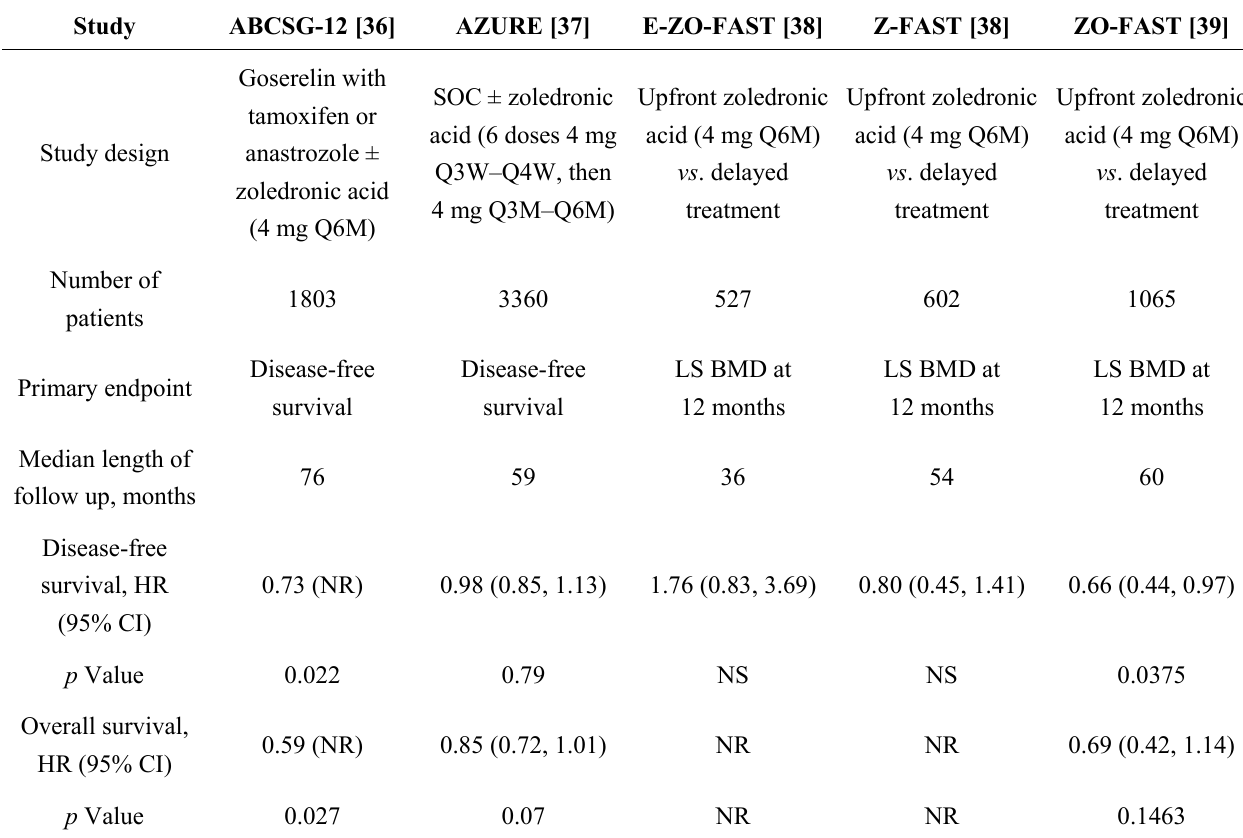
Table 2. Results of five large, open-label clinical trials investigating the adjuvant use of zoledronic acid in patients with breast